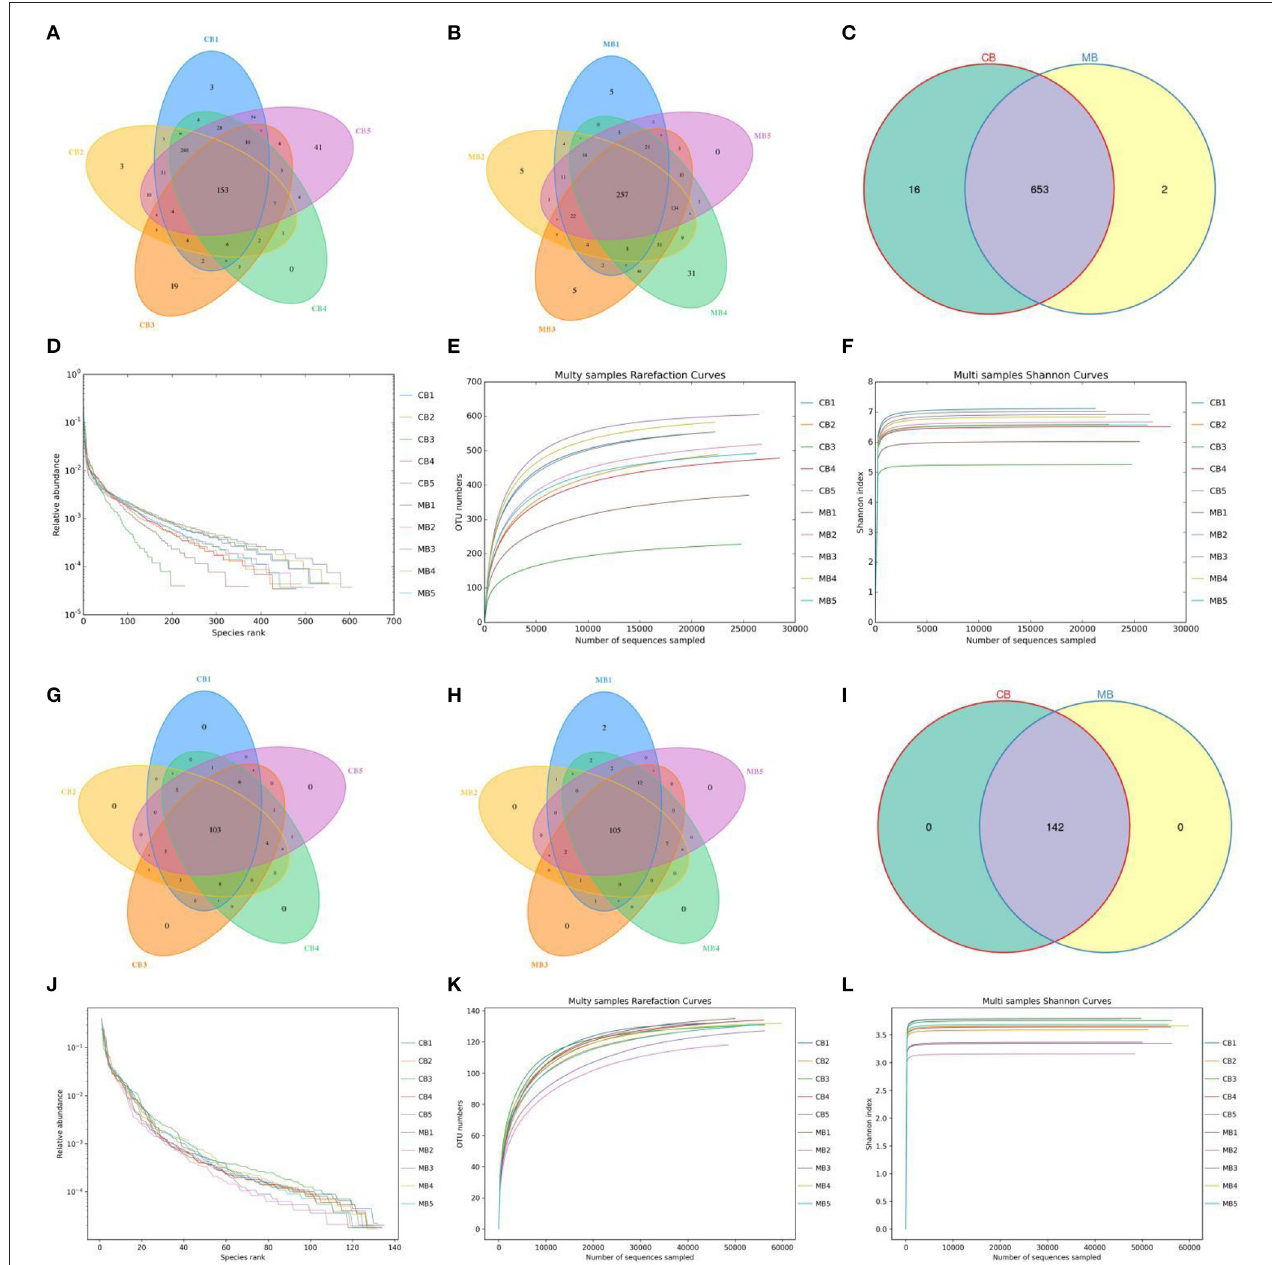
FIGURE 1 | Operational taxonomic units (OTUs) distribution and sequencing data analysis. Venn diagrams for gut bacterial (A–C) and fungal (G–I) OTUs distribution. Gut bacterial (D–F) and fungal (J–L) sequencing depth and evenness were assessed by rank abundance and rarefaction curves.